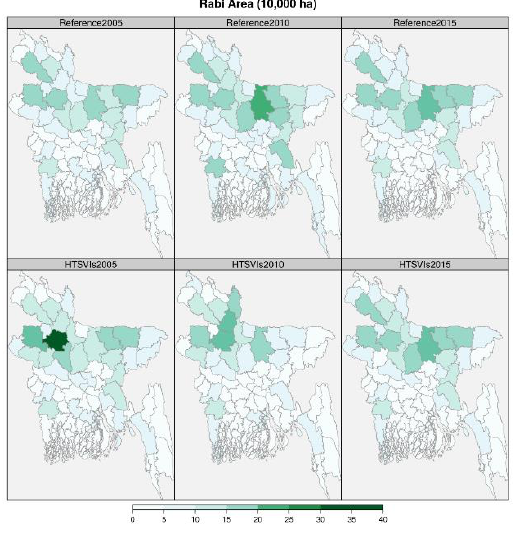
Figure 5. District maps of dry season rice production: Reference vs. HTS-VIs closest